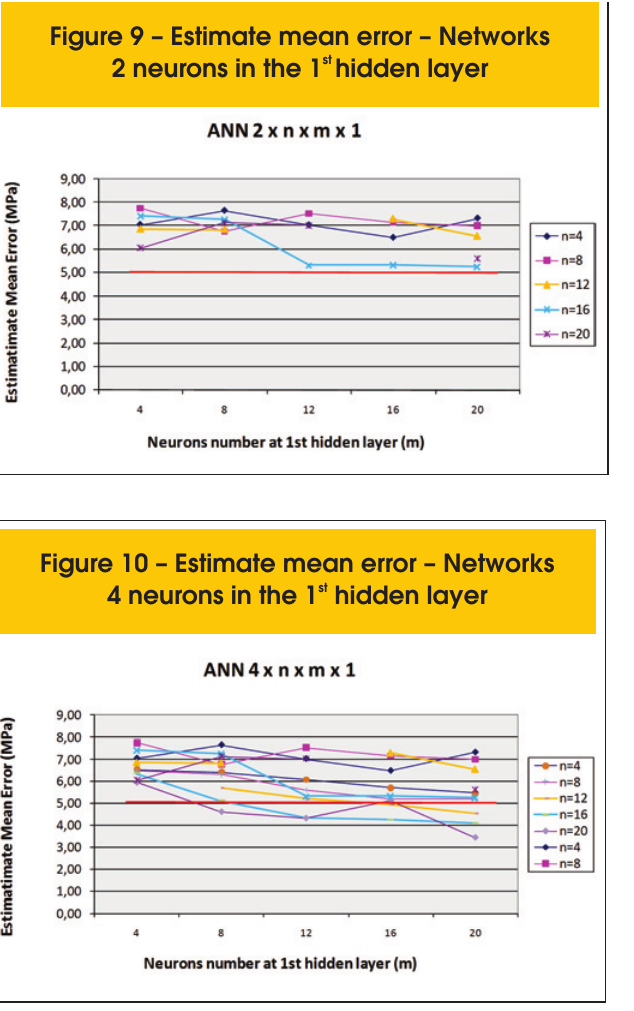
Figure 9 – Estimate mean error – Networks st 2 neurons in the 1 hidden layer